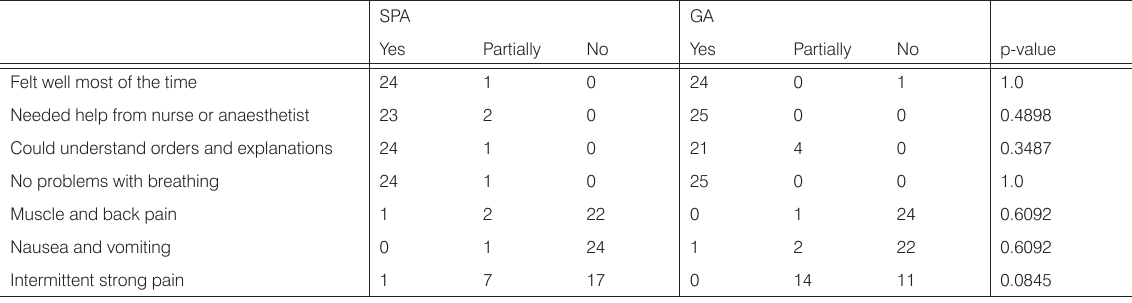
Table 5. Patient satisfaction concerning anaesthetic care.